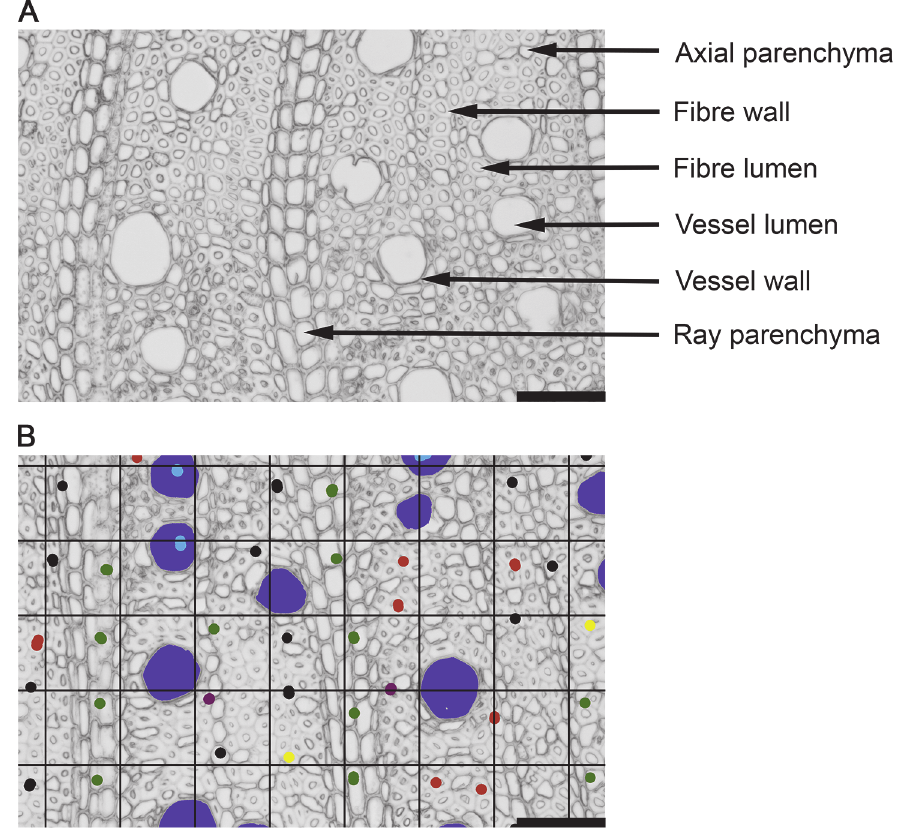
Fig 1. Illustration of wood tissues (A) and the image analysis method applied in this study (B), shown on an example of Gomphandra australiana , Icacinaceae. (B) Vessels were manually coloured (large circles in dark blue) and then the vessel areas ware measured in image analysis software (see text for details). Grid method was used to estimate tissue fractions. Grid points were marked according to the tissue they fell in: light blue — vessel lumen, purple — vessel wall, red — axial parenchyma, green — ray parenchyma, yellow — fibre lumen and black — fibre wall. For clarity, the picture illustrates only a fragment of a larger, pie- shape area analysed. Scale bar corresponds to 100 μ